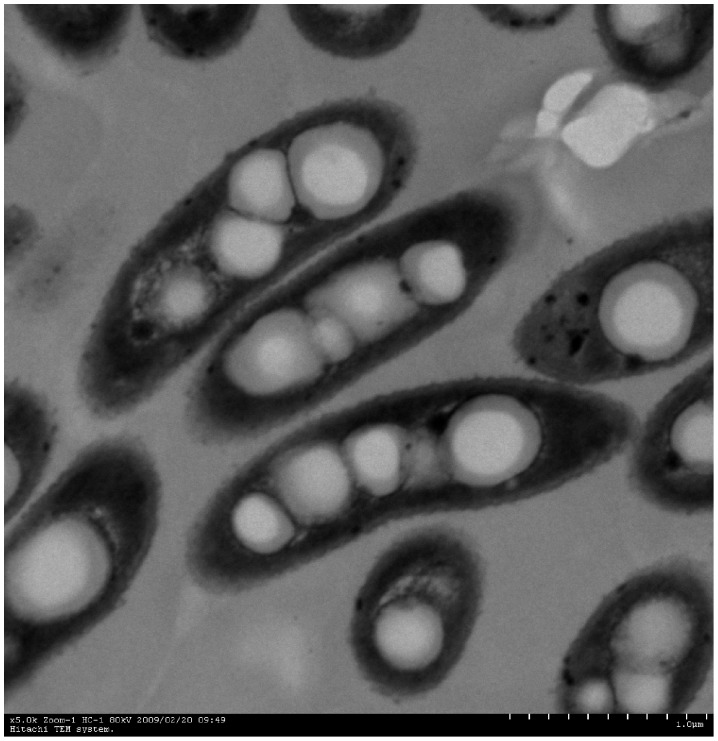
Transmission electron micrograph of a cell of strain GIMN1.004T, bar 1 µm.